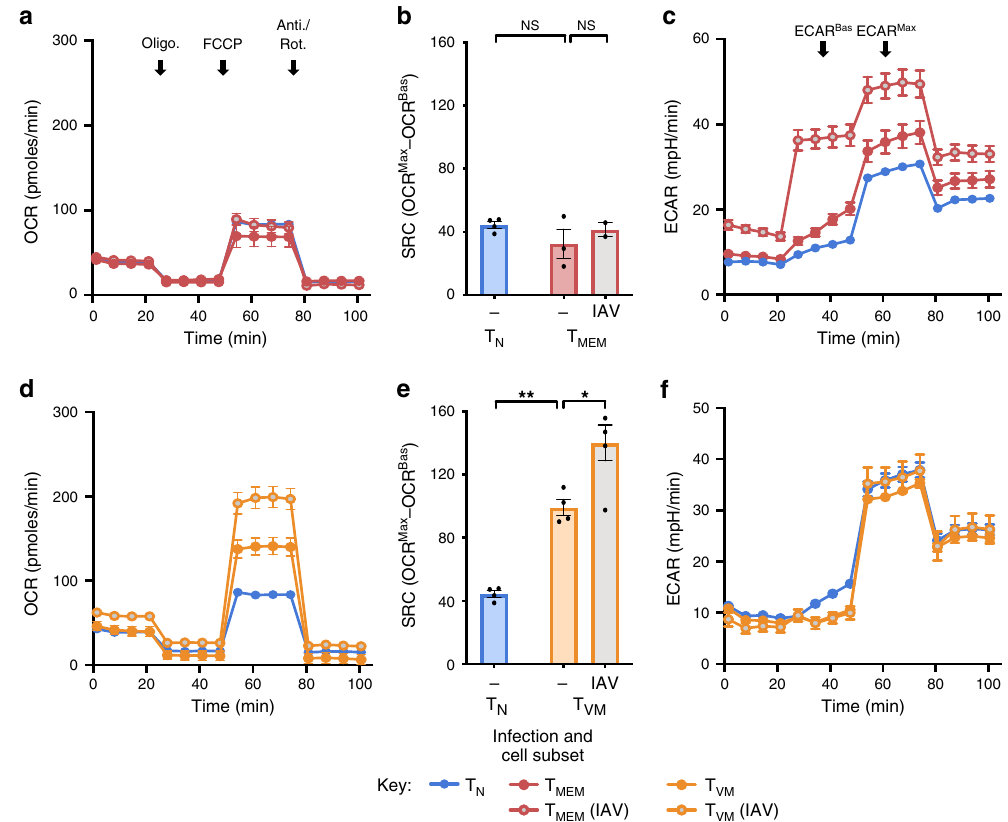
Fig. 2 T VM cells increase SRC with recent infection. a OCR for sorted T N and T MEM cells from the spleens of uninfected young SPF mice or Tetramer + T MEM (IAV) cells from IAV-infected mice (20 days post infection) and b change in OCR for each sorted subset ( n = 4 – 2, 3 experimental replicates). c ECAR for sorted T N and T MEM cells from young uninfected mice or Tetramer + T MEM (IAV) cells from IAV-infected mice (20 days post infection), with ECAR Bas and ECAR Max indicated ( n = 2 – 4, 3 experimental replicates). d OCR for sorted T N and T VM cells from young uninfected mice or T VM (IAV) cells from IAV-infected mice (20 days post infection) and e change in OCR for each sorted subset ( n = 4 – 5, 3 experimental replicates). f ECAR for sorted T N and T VM cells from young uninfected mice or IAV-infected mice (20 days post infection) ( n = 5, 3 experimental replicates). Shown is mean ± SEM. NS indicates not signi fi cant, * indicates p ≤ 0.05, ** indicates p ≤ 0.01, unpaired t